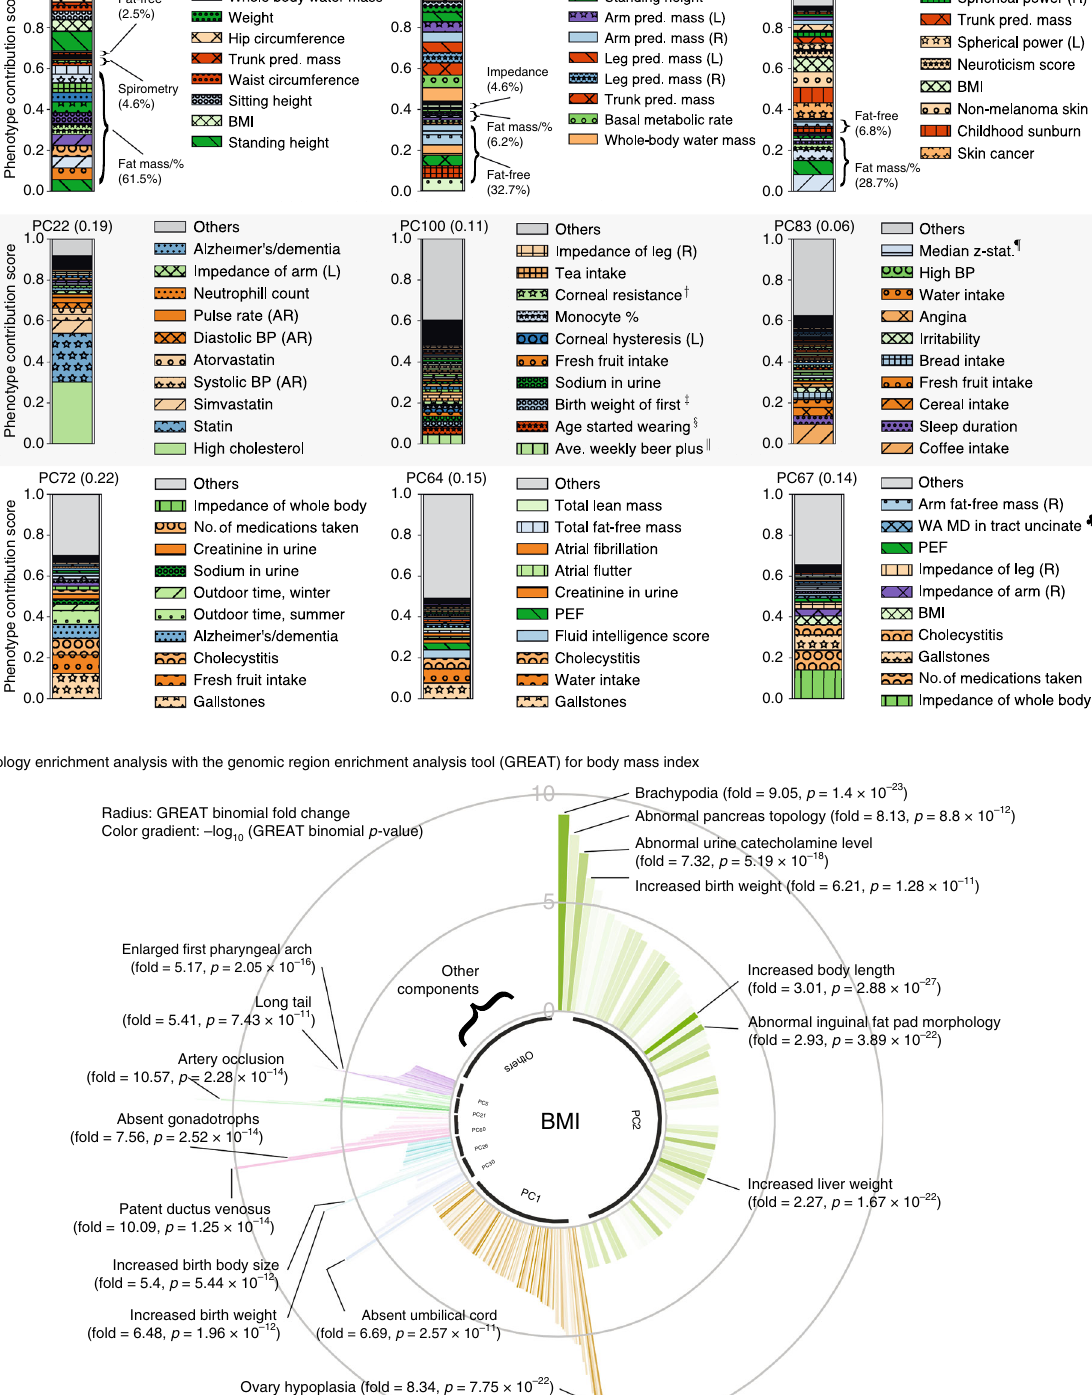
components using Jaccard index (Methods). Jaccard index is a set similarity measure ranges between zero and one, where one means the complete match and zero means complete disjoint of the two sets. We found the median of the pairwise similarity to be 0.029 (Supplementary Fig. 19).